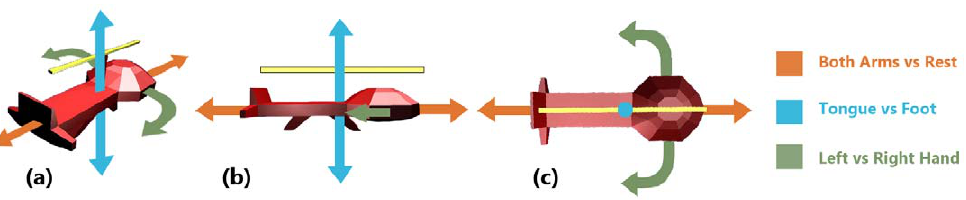
Figure 2. Three-dimensional helicopter control arrangements are shown in perspective (a), side (b) and top (c) views. Users have independent control of forward, backward, up, down, and left and right rotation about the helicopter’s z-axis. To go forward or back, subjects imagine moving or resting both hands respectively. To rotate the helicopter left or right, subjects imagine moving either the left or right hand respectively. Subjects imagine moving the tongue to raise the helicopter and moving the feet to lower it. Each control can be independently adjusted in strength according to user preference.